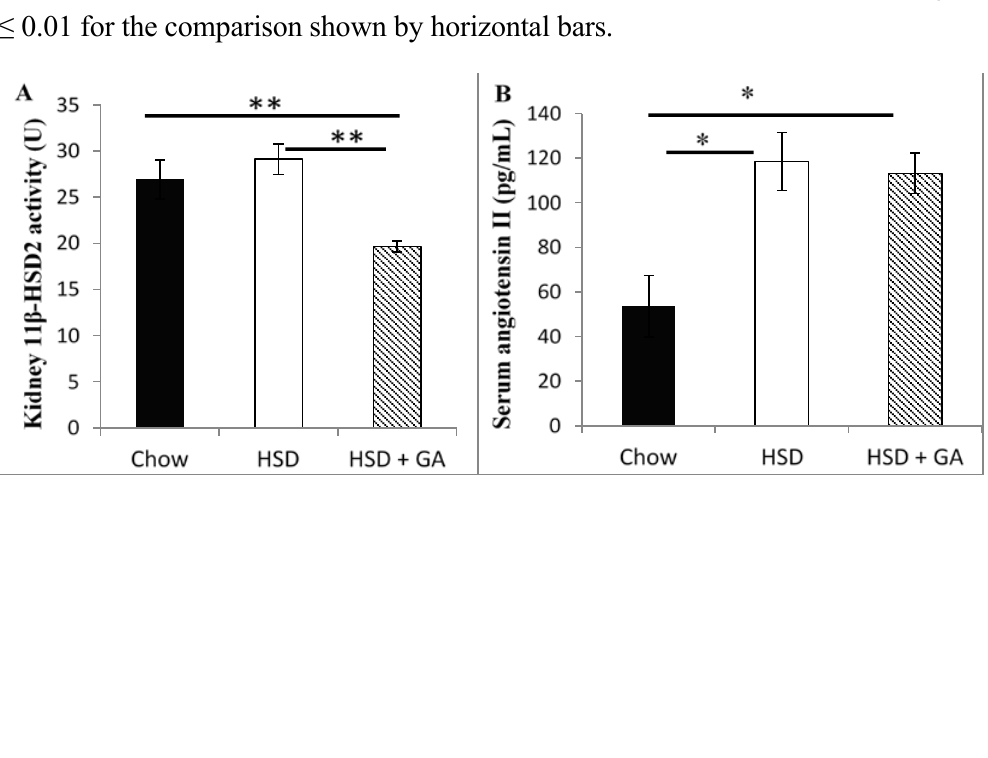
( B ) serum angiotensin II concentrations; ( C ) serum electrolyte concentrations